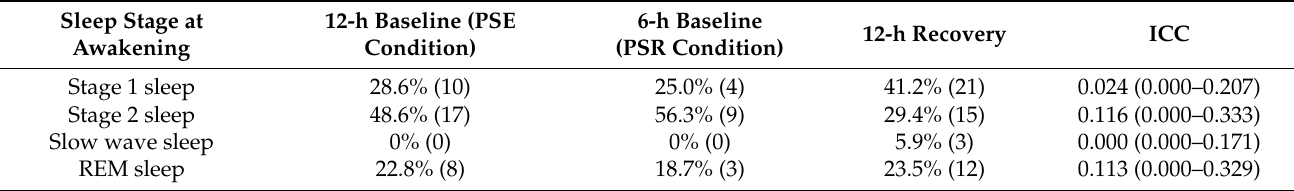
Table 1. Breakdown of polysomnographically assessed sleep stages from which participants woke up in the baseline and recovery sleep periods. The table shows percentages (and counts) of the different sleep stages for the distinct types of sleep periods in the study, as well as intraclass correlation coefficient (ICC) values (and their 95% confidence intervals) for systematic interindividual differences.